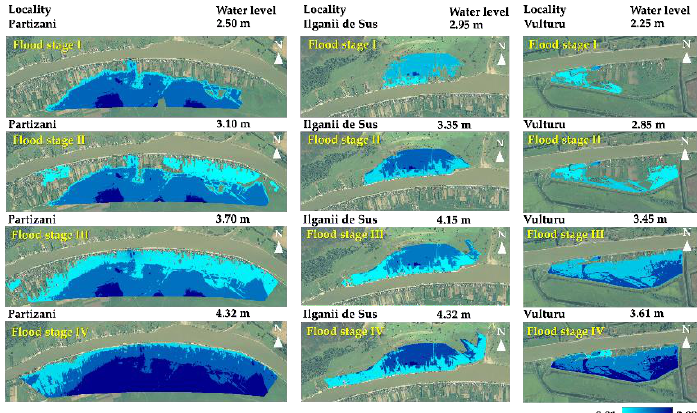
Figure 11. Flood scenarios maps for Partizani (first column group of subfigures), Ilganii de Sus (second column group of subfigures), and Vulturu (third column group of subfigures) settlements, corresponding to the condition of 7 July 2010, by using the 1D / 2D HEC-RAS model, at high resolution DTM 0.5 m × 0.5 m, dynamic method.